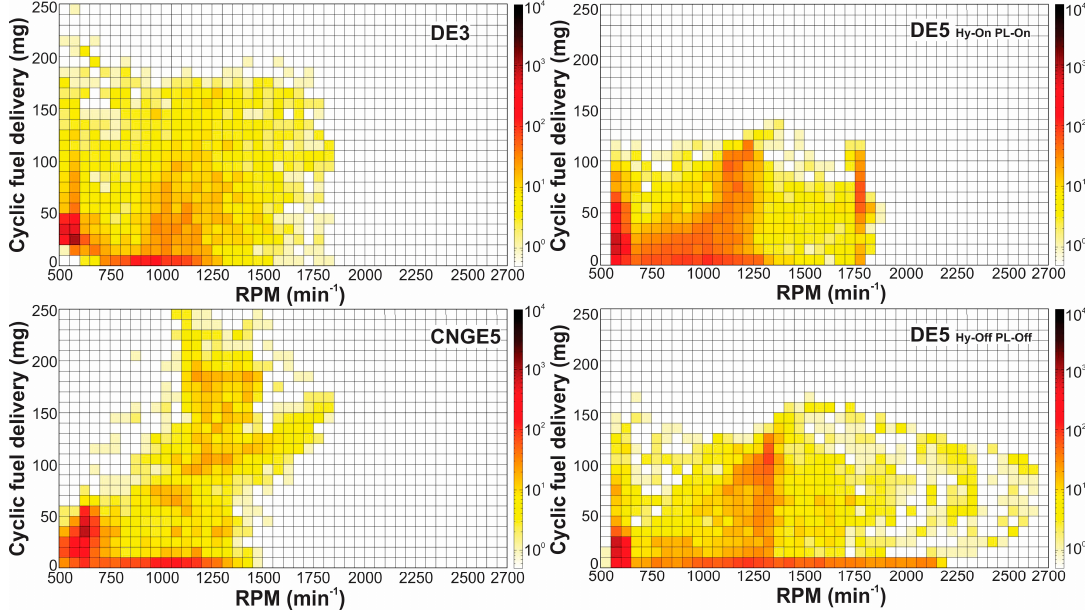
Figure 6. Cyclic fuel delivery of the DE3 bus, CNGE5 bus, DE5 bus in hybrid mode with power limiter on and in non-hybrid mode with power limiter off.